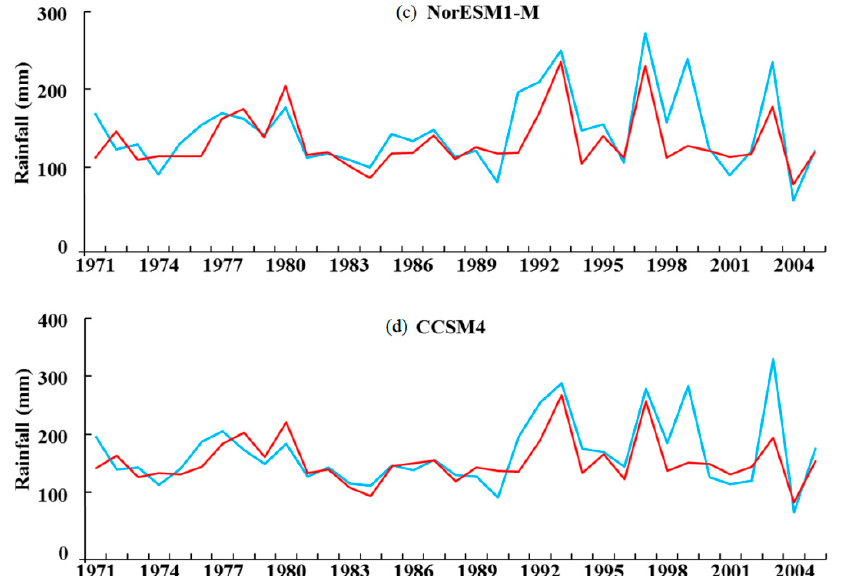
Figure 5. Comparison of observed hourly maximum rainfall and observed daily rainfall disaggregated to hourly maximum rainfall using ANN approach at station Kedah for ( a ) BCC-CSM 1.1 for 1 h ( b ) HadGEM2-ES for 3 h ( c ) Nor-ESM-M for 12 h and ( d ) CCSM4 for 72 h.